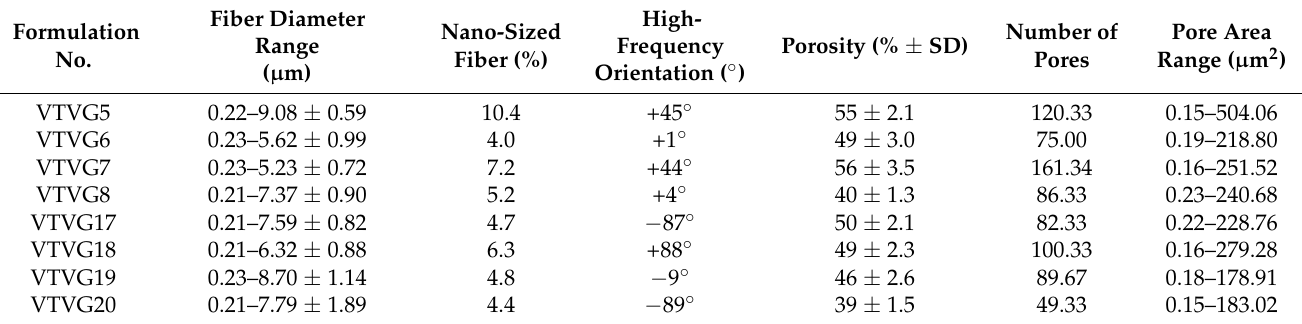
Table 3. Fiber characterization by SEM ImageJ